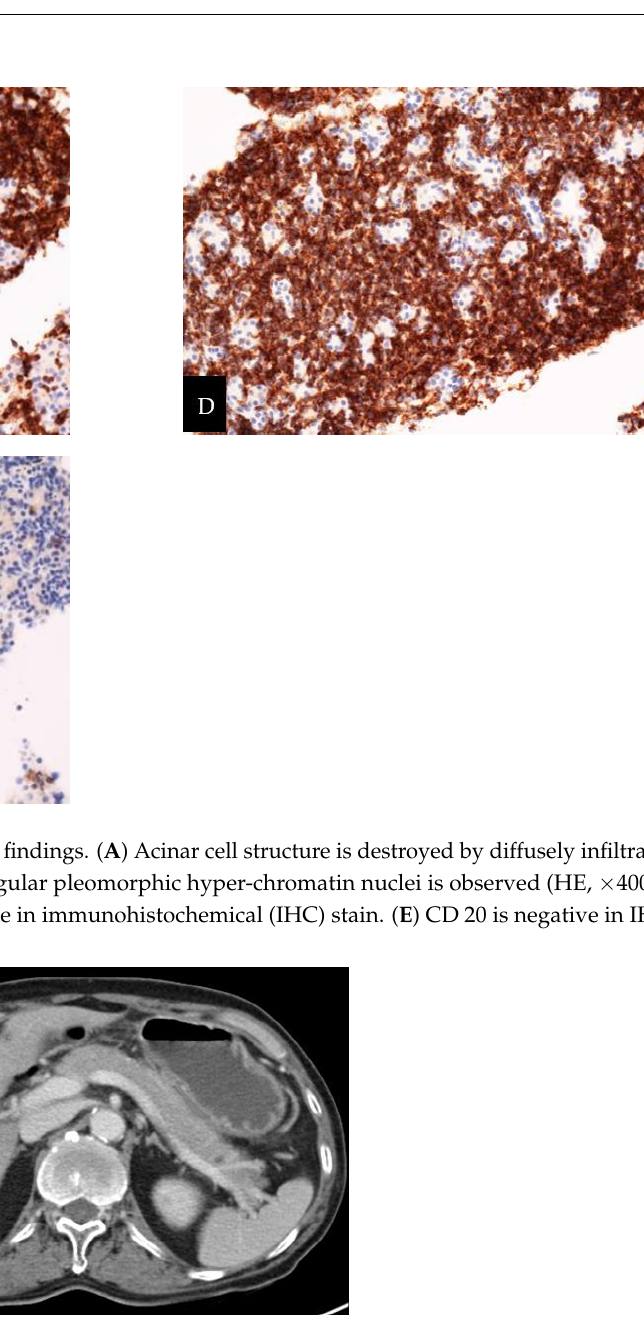
Figure 5. CT finding after 2 months. Pancreatitis is improved and no complication is observed.